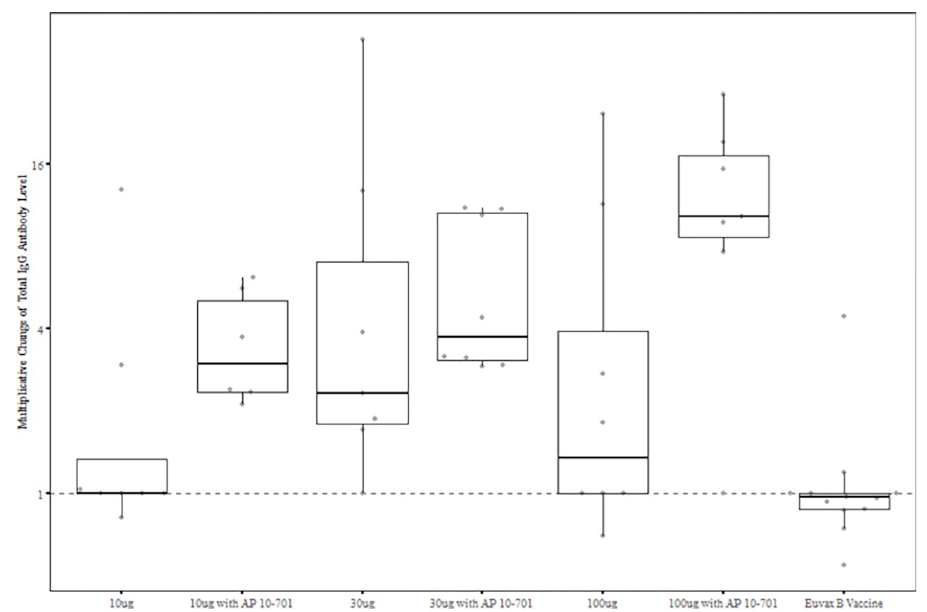
Fig 5. Fold change from baseline in anti- Sm -TSP-2 IgG levels at study day 127 by vaccine group. Per-protocol immunogenicity population. Vaccinations were administered on study days 1, 57, and 113. Error bars represent 95% confidence intervals. Euvax B hepatitis B recipients were pooled across cohorts.